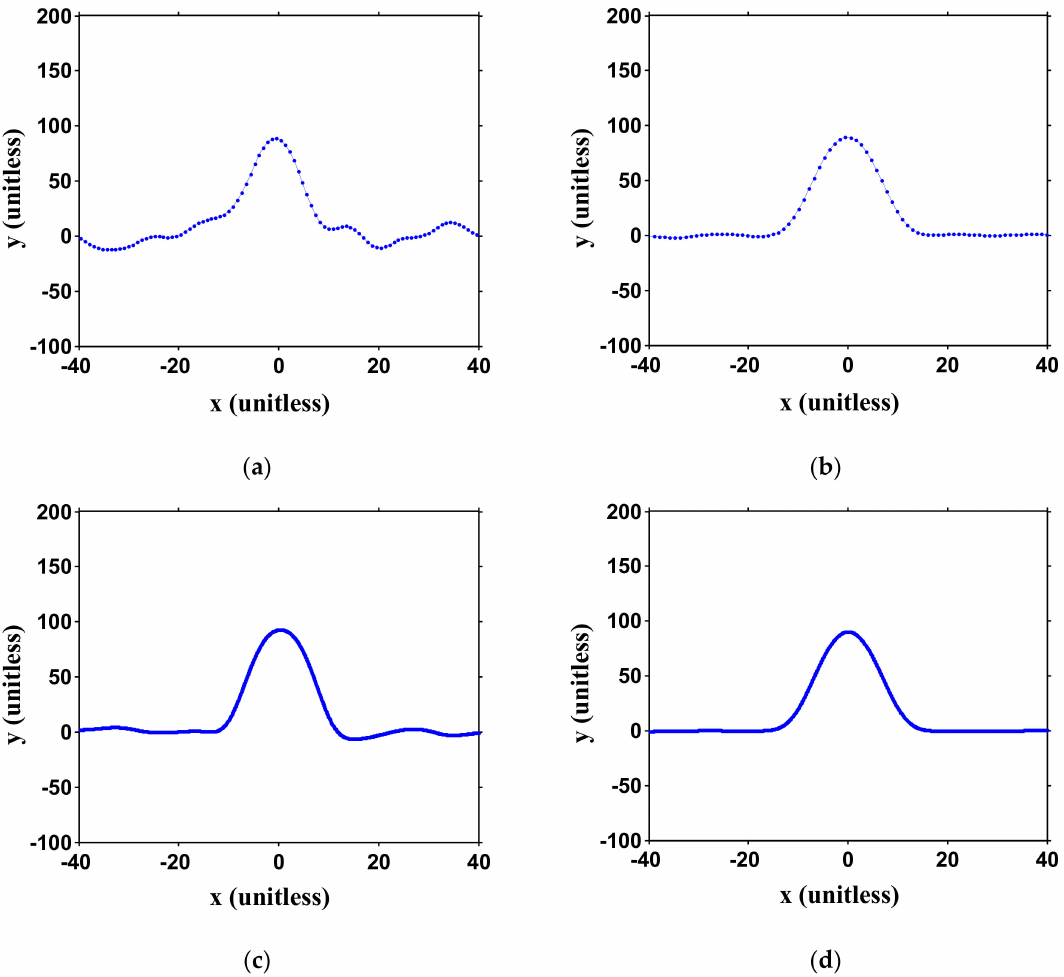
Figure 5. Emulated captured curves under different conditions after filter. The ideal curve above the noise level is set as y = − x 2 + 100. Left column ( a , c ): SNR = 10 dB; right column ( b , d ): SNR = 30 dB; top row ( a , b ): N p = 20; bottom row ( c , d ): N p = 200. N p : number of points within the parabolic curve. Curves are unitless, as illustrated in Figure